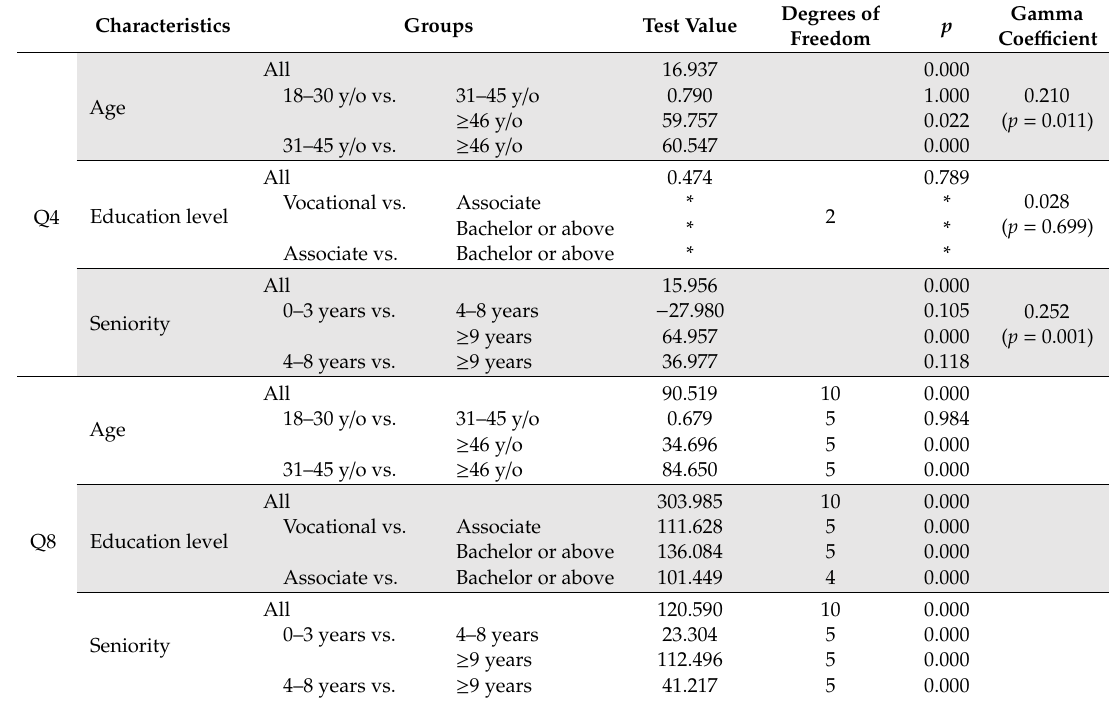
Table 3. Di ff erences between age, education level, and seniority groups for Q4 (willingness to improve) and Q8 (satisfaction of academic